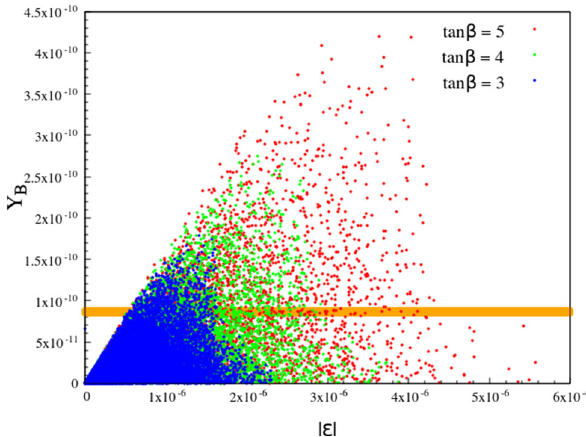
Fig. 5 Parameter space in Y B − | (cid:3) | plane with varying M 1 , M 2 , M 3 . Blue, green and red points correspond to the regions with tan β = 3 , 4 , 5. The Orange band signifies 2 σ -deviation from the central